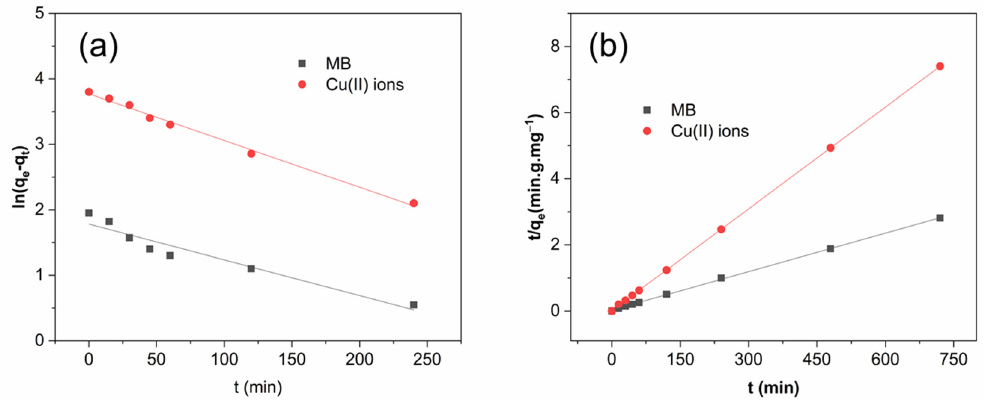
Figure 7. ( a ) Pseudo-second-order kinetic model and ( b ) pseudo-first-order kinetic model for MB and Cu (II) ions adsorption on the HGC-2 beads. Experimental conditions: 100 mg of dried HGC-2 beads, 100 mL solution, pH 8.0 (MB) or pH 5.0 (Cu(II) ions) under room temperature. Table 3. Kinetic parameters in the adsorption of MB and Cu(II) ions onto the HGC-2 sample.